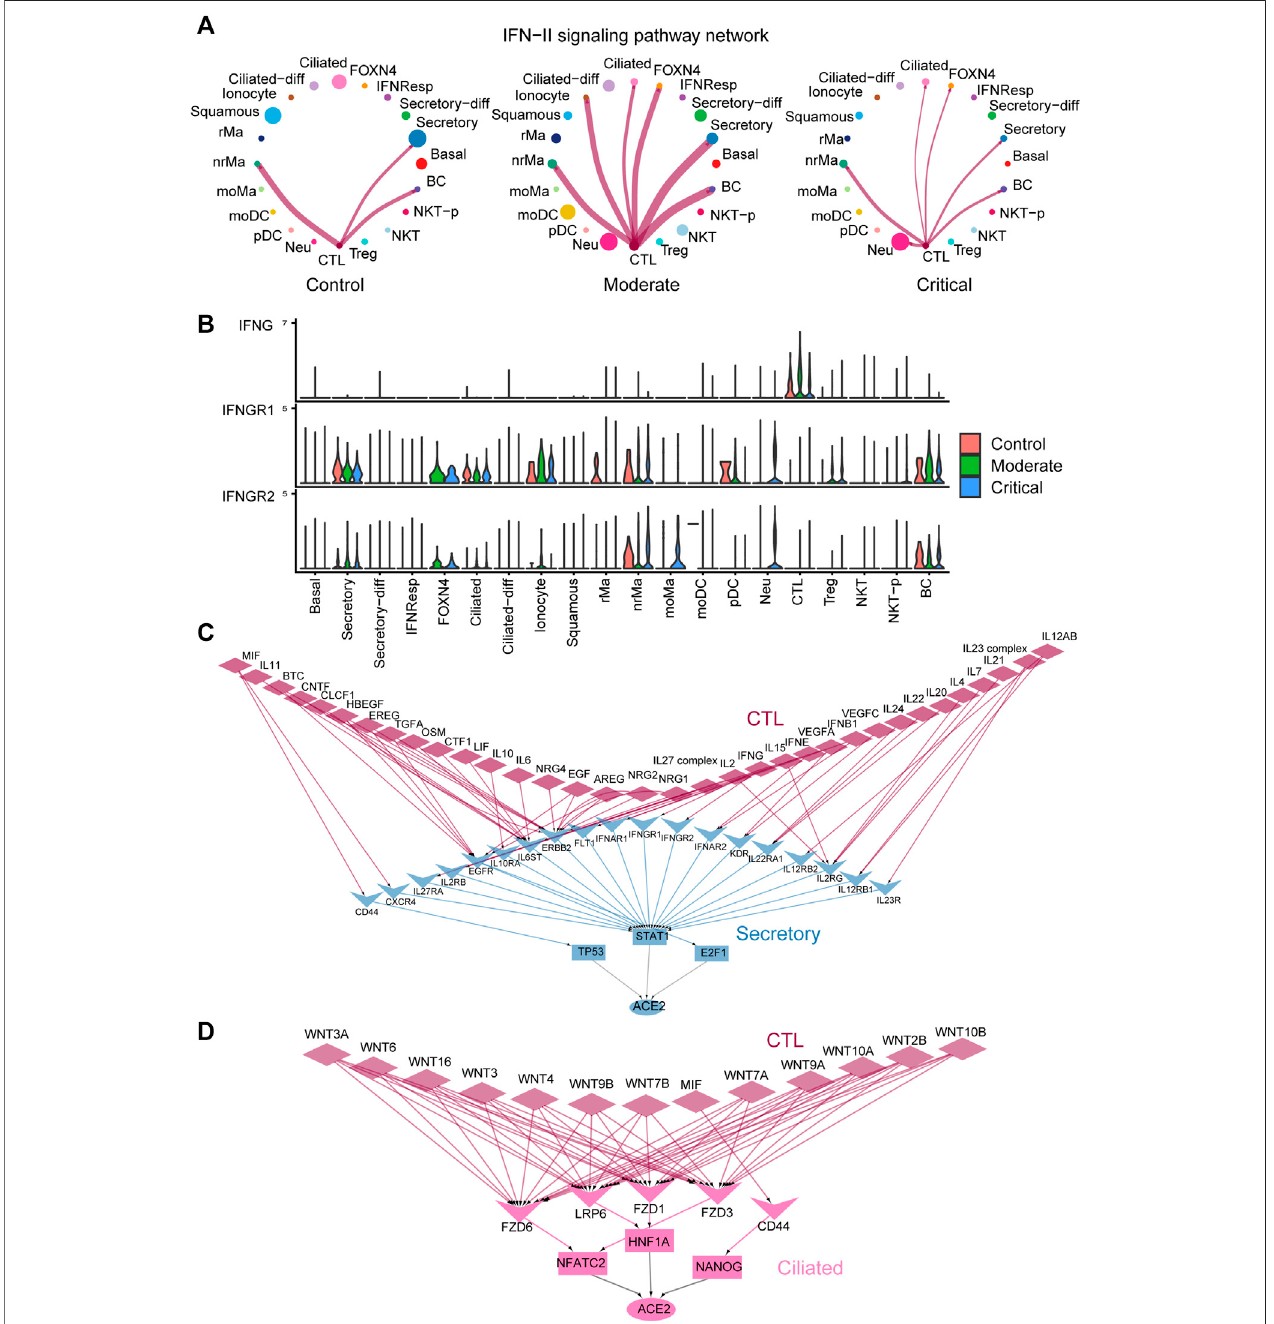
FIGURE5| MultiscalesignalingnetworkofCTL-to-secretoryandCTL-to-ciliatedrevealshowintercellularcommunicationactivatestheACE2expression via TFsin COVID-19. (A) Circle plots depicting the inferred IFN-II cell – cell communication networks between different cell groups in control, moderate, and critical. (B) Expression of IFN-II signaling – related genes such as IFNG, IFNGR1, and IFNGR2 in control, moderate, and critical COVID-19. (C) The inferred multiscale signaling network of CTL- to- secretory in critical COVID-19. (D) The inferred multiscale signaling network of CTL-to- ciliated in critical COVID-19.